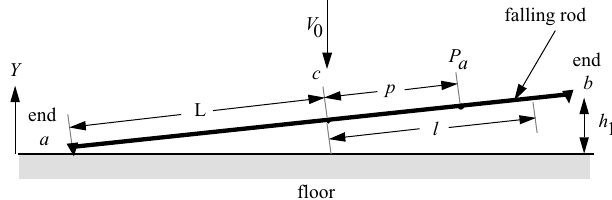
Fig. 1. Schematic of a bar falling vertically without rotation in an almost-horizontal configuration, and striking the ground with its left end, a , first. As a result of this collision, the bar is set into rotation, and experiences a rapid sequence of alternating-end impacts before it bounces free of the ground. We call this rapid sequence of impacts, which make up a single rebound, ‘clattering’. The dynamics of this motion are governed primarily by the mass distribution of the bar and its coefficient of restitution. The point P a represents the center of precussion for impacts at a . For impacts at end b , the center of percussion, P b , is at a distance p to the other side of the CM. ) / ( L 2 + ρ 2 ) is an inertial 15].) q ≡ ( L 2 − ρ 2 g g